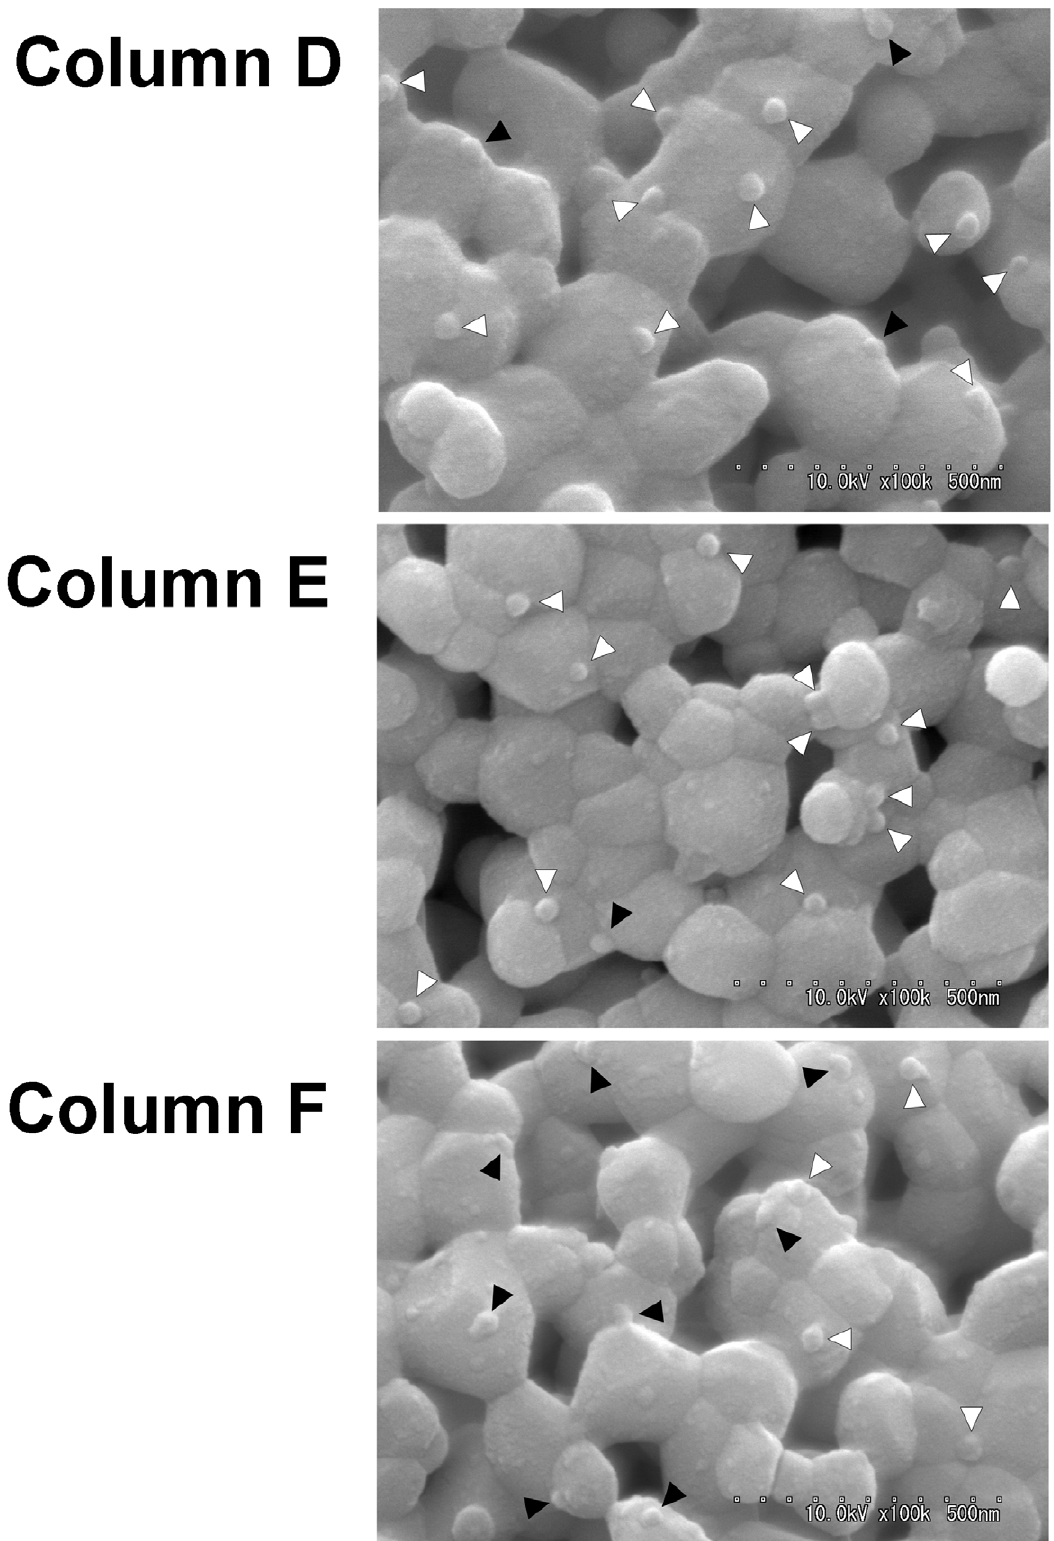
Figure 5. Observation of HAp surfaces that were incubated under 3 different conditions. Column D: no incubation; Column E: incubated at 2 u C for 7 days; Column F: incubated at 37 u C for 7 days. HAp particles of the column head were observed with scanning electron microscopy. The white triangles indicate spherical-shaped viruses. The black triangles indicate flat-shaped viruses.